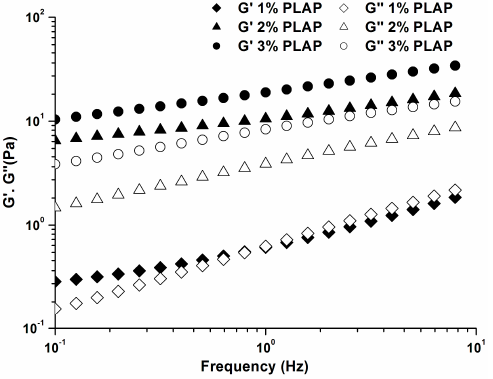
Figure 3. Effect of polysaccharide concentration on storage (G ′ ) and loss (G ′ ’) moduli of PLAP at 25 °C.